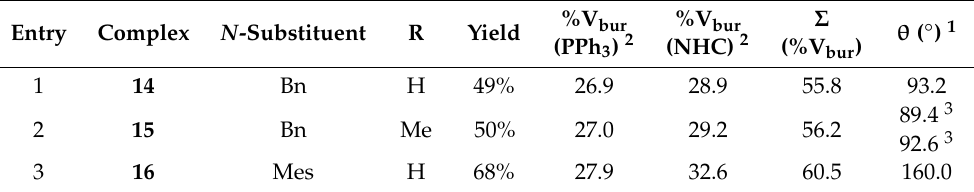
Table 2. Properties of Ir-carbonyl complexes 14 – 16 .